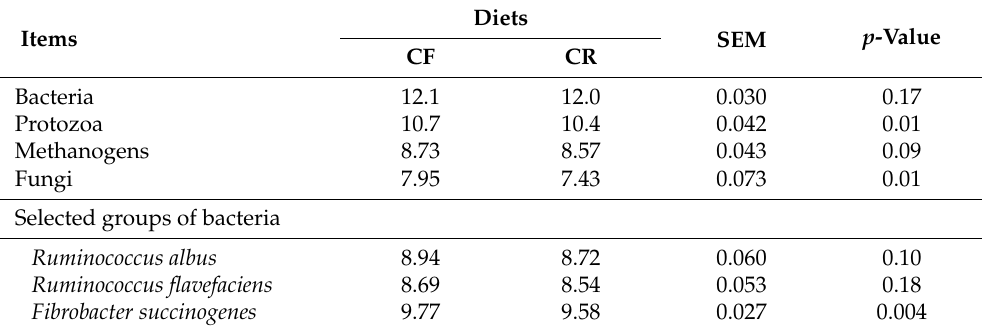
Table 7. Selected microbial groups (log 10 gene copies per mL rumen content) in the rumen of beef cattle fed corn stover after fresh-corn harvested (CF) or corn stover after ripe-corn harvested (CR) silage diet (n =